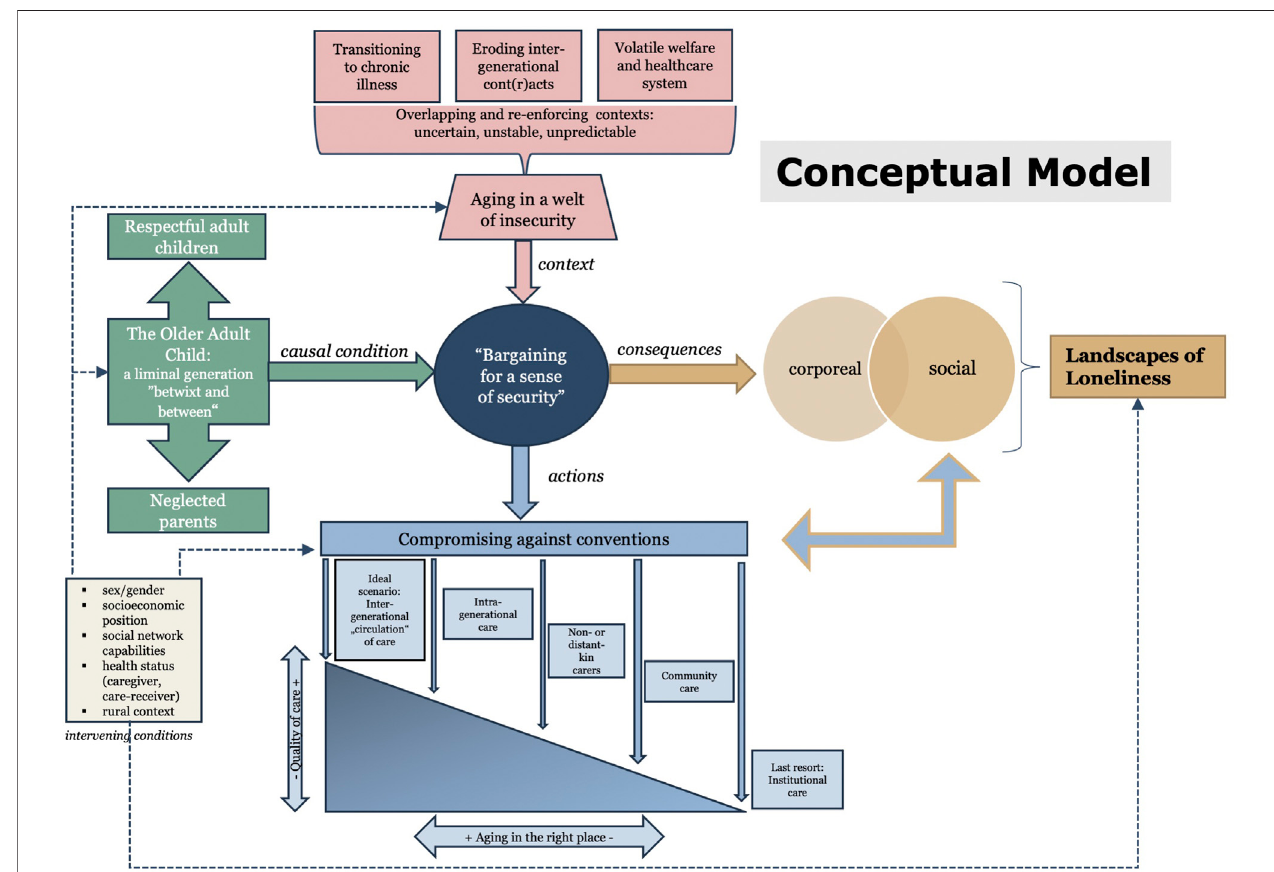
FIGURE 3 | ‘ Bargaining for a sense of security ’— a conceptual model how ‘ older adult children ’ experience their aging.